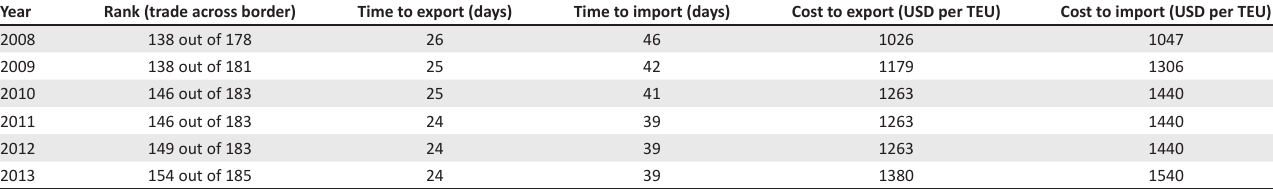
TABLE 1: Nigeria’s international ranking in trading across borders. Rank (trade across